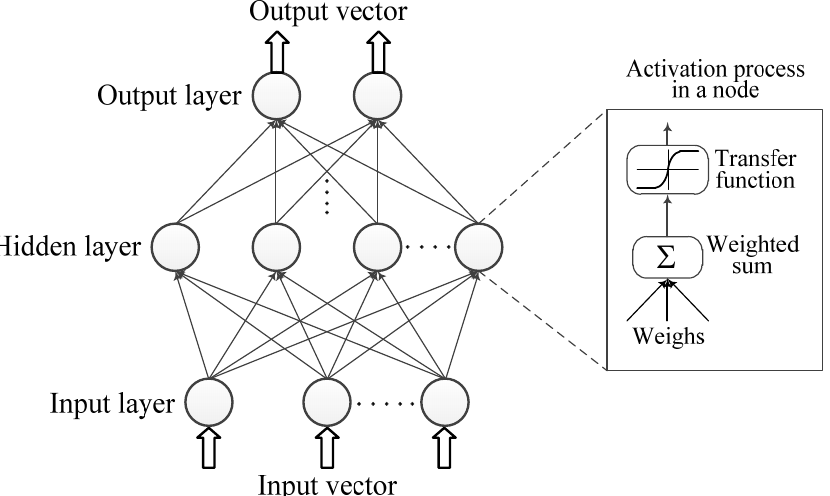
Figure 4. A typical architecture of multilayered feedforward